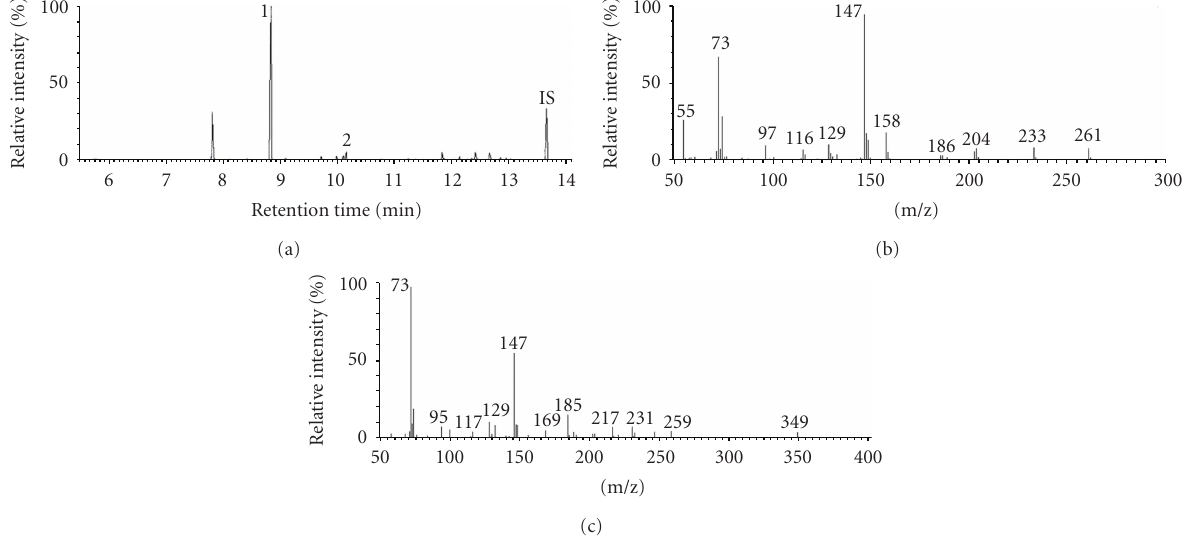
Figure 1: Chemical diagnosisof glutaric acidemia type I by GC-MS analysisof urinary metabolites for a 9-month-old female with motor and language retardation. Figure 1(a) is a representative GC-MS total ion current (TIC) profile, in which intensities of peak 1 and 2 were both dramatically increased. IS is the abbreviation of internal standard. Figures 1(b) and 1(c), the mass spectra for peak 1 and 2 in Figure 1(a), revealed their identifications as trimethylsilyl derivatives of glutarate and 3-hydroxyglutarate, respectively.